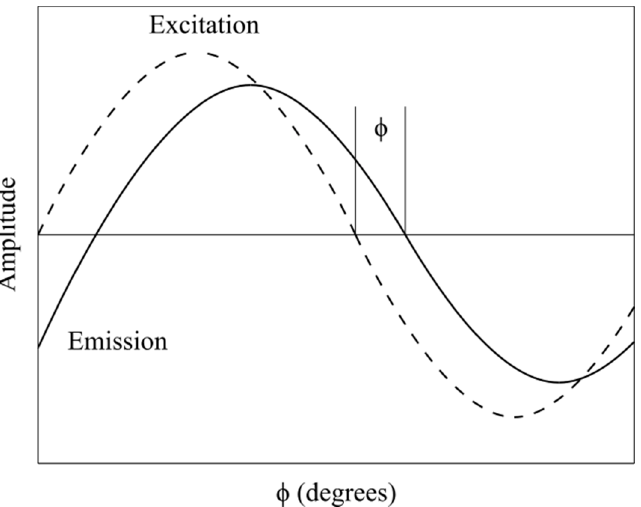
φ of sinusoidally modulated emitted light